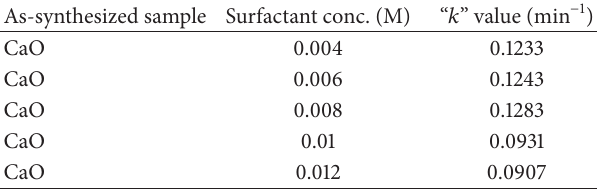
Table 1: Effect of surfactant concentration on catalytic activity of